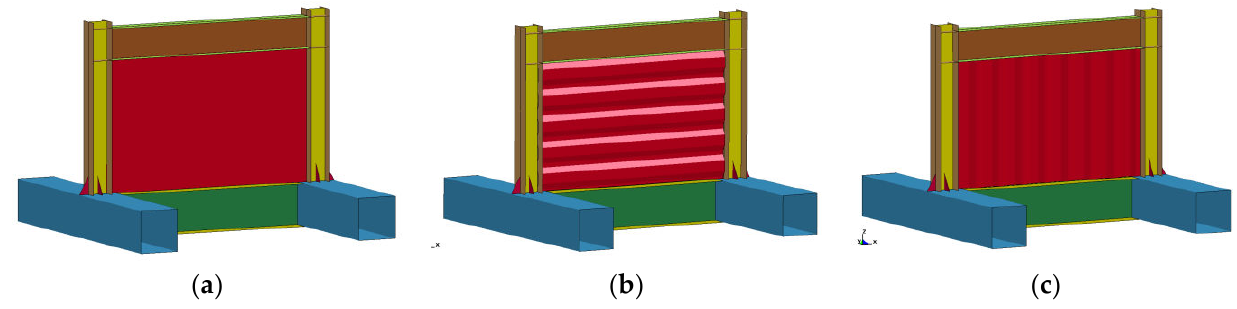
Figure 7. FEM of the walls with ( a ) flat, ( b ) horizontal corrugated, and ( c ) vertical corrugated steel plate.